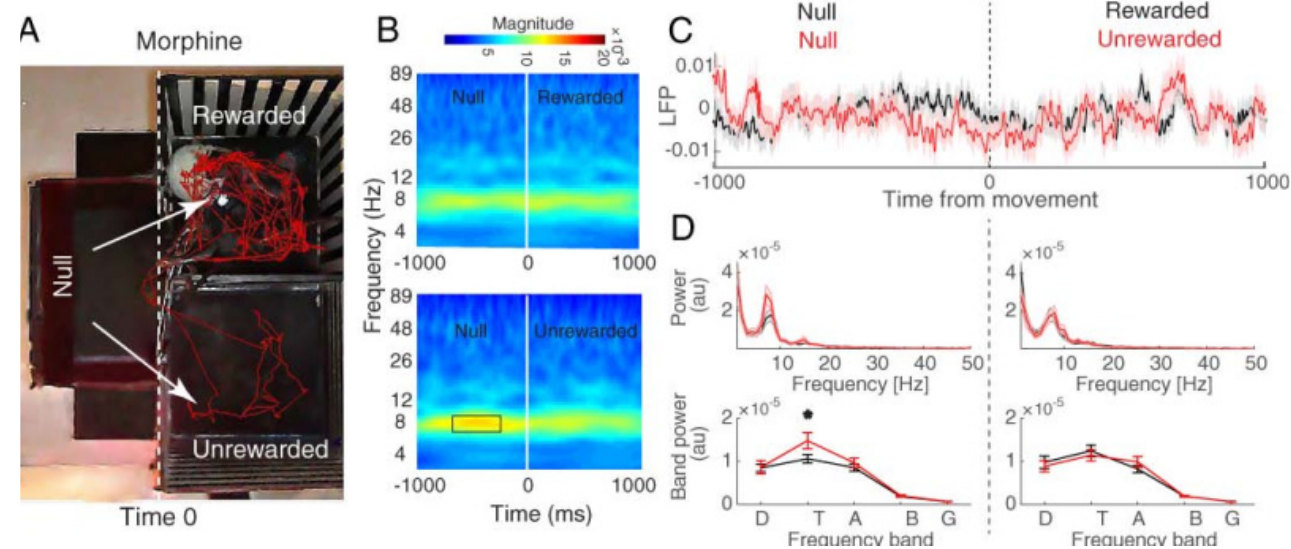
Figure 4. Hippocampal CA1 local field potential of morphine group. ( A ) Behavioral tracking of animals during LFP recording in the post-test session of CPP (red line), animals received morphine in the rewarded compartment while receiving saline in the unrewarded compartment. The dashed line indicates the time that the rat chooses to enter the rewarded or unrewarded side from null. The time window was defined as one millisecond before and after the entrance to each side (null–rewarded and null–unrewarded sessions). ( B ) Time–frequency representation based on CWT averaged across all recording trials and aligned to chamber entry. This figure shows the earliest modulation of theta frequency before time zero ( − 727 to − 153 ms). Power in theta band peaked before the entrance to unrewarded side (top). Time zero is defined as the time of entrance to each side from null (shown by the dashed line). ( C ) Total averaged waveform (top) and ( D ) mean power distributions (bottom) for the approach to the rewarded (black) and unrewarded (red) compartment calculated over a time window of 1 s before and 1 s after chamber entry. Results indicate that mean theta power is increased before the entrance to the unrewarded compartment. Shaded areas represent SEM. * p < 0.05 as compared with the null–rewarded session.